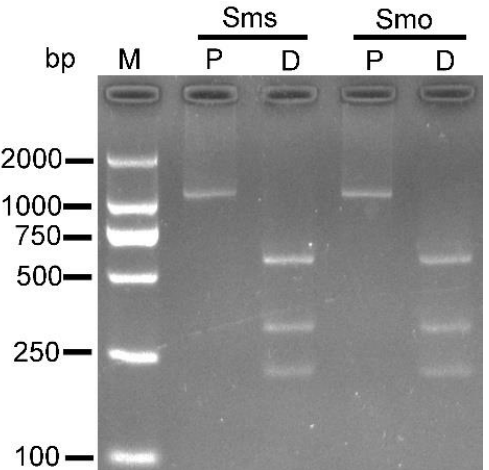
Figure 3. Results of PCR with primers SF1/SR9 and restriction enzyme digestion with ClaI and AvaII of sarcocyst and oocyst DNA from Sarcocystis masoni . M, molecular mass marker; Sms, S . masoni sarcocyst; Smo, S . masoni oocyst; P, PCR product; D, digestion of PCR product with ClaI and AvaII.